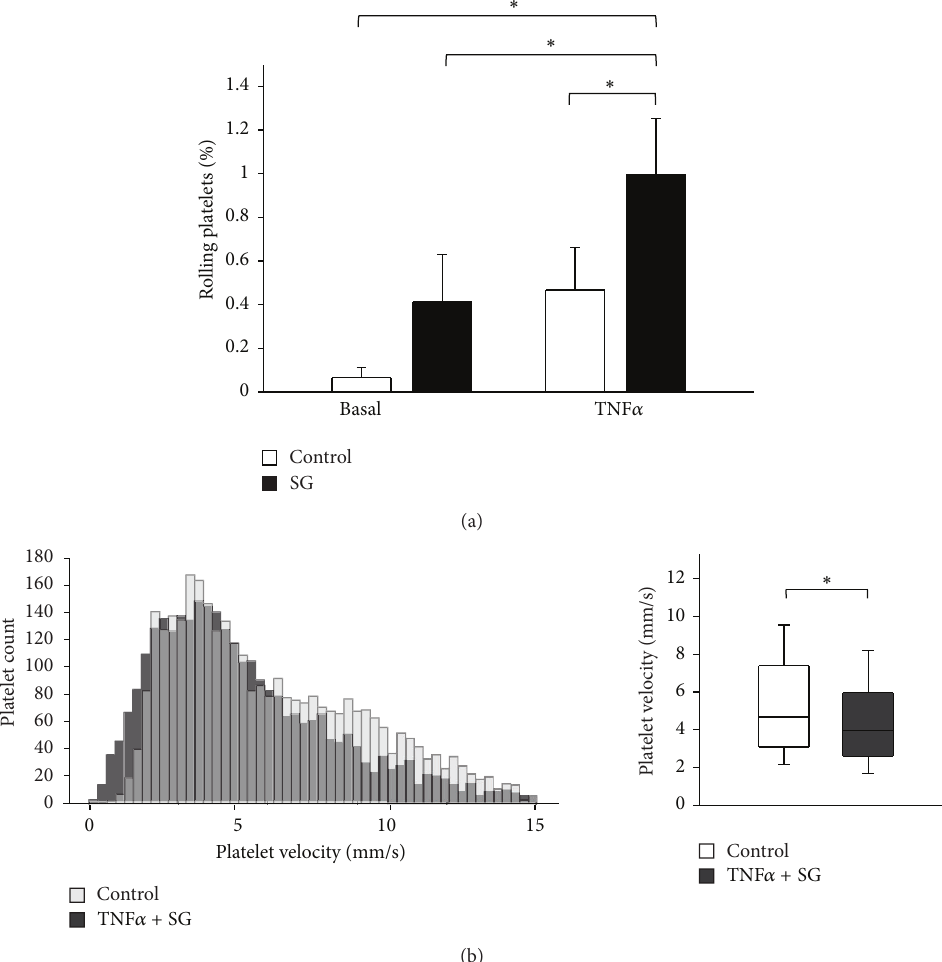
Figure 1: Inhibition of SHP-1 leads to increased platelet rolling in vivo in TNF 𝛼 -induced systemic inflammation. (a) In vivo the amount of rolling platelets (defined as platelets with a velocity of less than 5% of maximal velocity) as analyzed by intravital microscopy in the dorsal skinfoldchamberwasslightlyenhanced invivo aftertreatmentwiththeSHP-1inhibitorsodiumstibogluconate(10 𝜇 g/mL,30min)underbasal conditionsbutsignificantlyincreasedinTNF 𝛼 -inducedinflammation(TNF 𝛼 5 ng/mL,4h).(b)InhibitionofSHP-1bysodiumstibogluconate in TNF 𝛼 -induced inflammation resulted in a leftward shift in platelet velocity distribution pattern (i.e., towards lower platelet velocities) in the frequency histogram, indicating increased transient platelet interaction with the endothelium. The histograms display all platelet velocities from 5 different animals per group. SG: sodium stibogluconate. ∗ Significantly different at 𝑃 < 0.05 ( 𝑛 = 2900 − 3300 platelets per group from 5 different